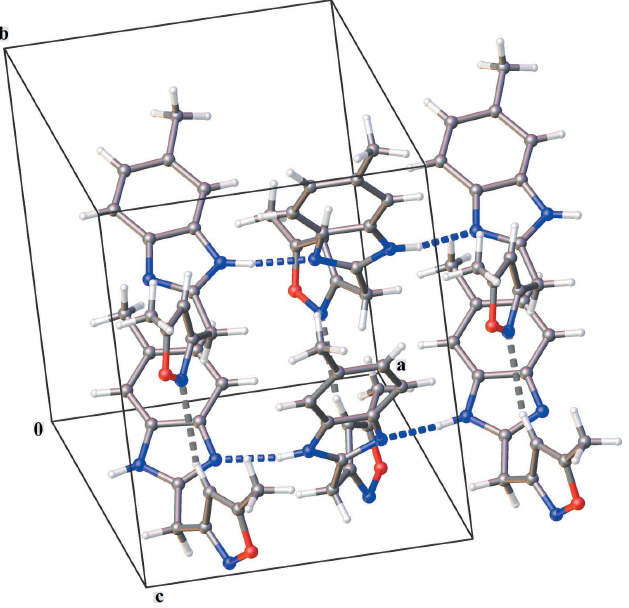
Figure 2 Partial crystal packing of the title compound. N—H (cid:3)(cid:3)(cid:3) N hydrogen bonds are shown by blue dashed lines and C—H (cid:3)(cid:3)(cid:3) N hydrogen bonds by gray dashed lines.